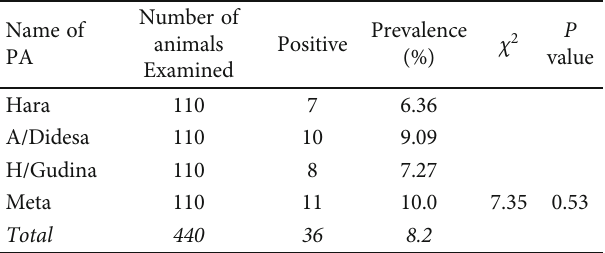
Table 1: The prevalence of bovine trypanosomiasis in the study